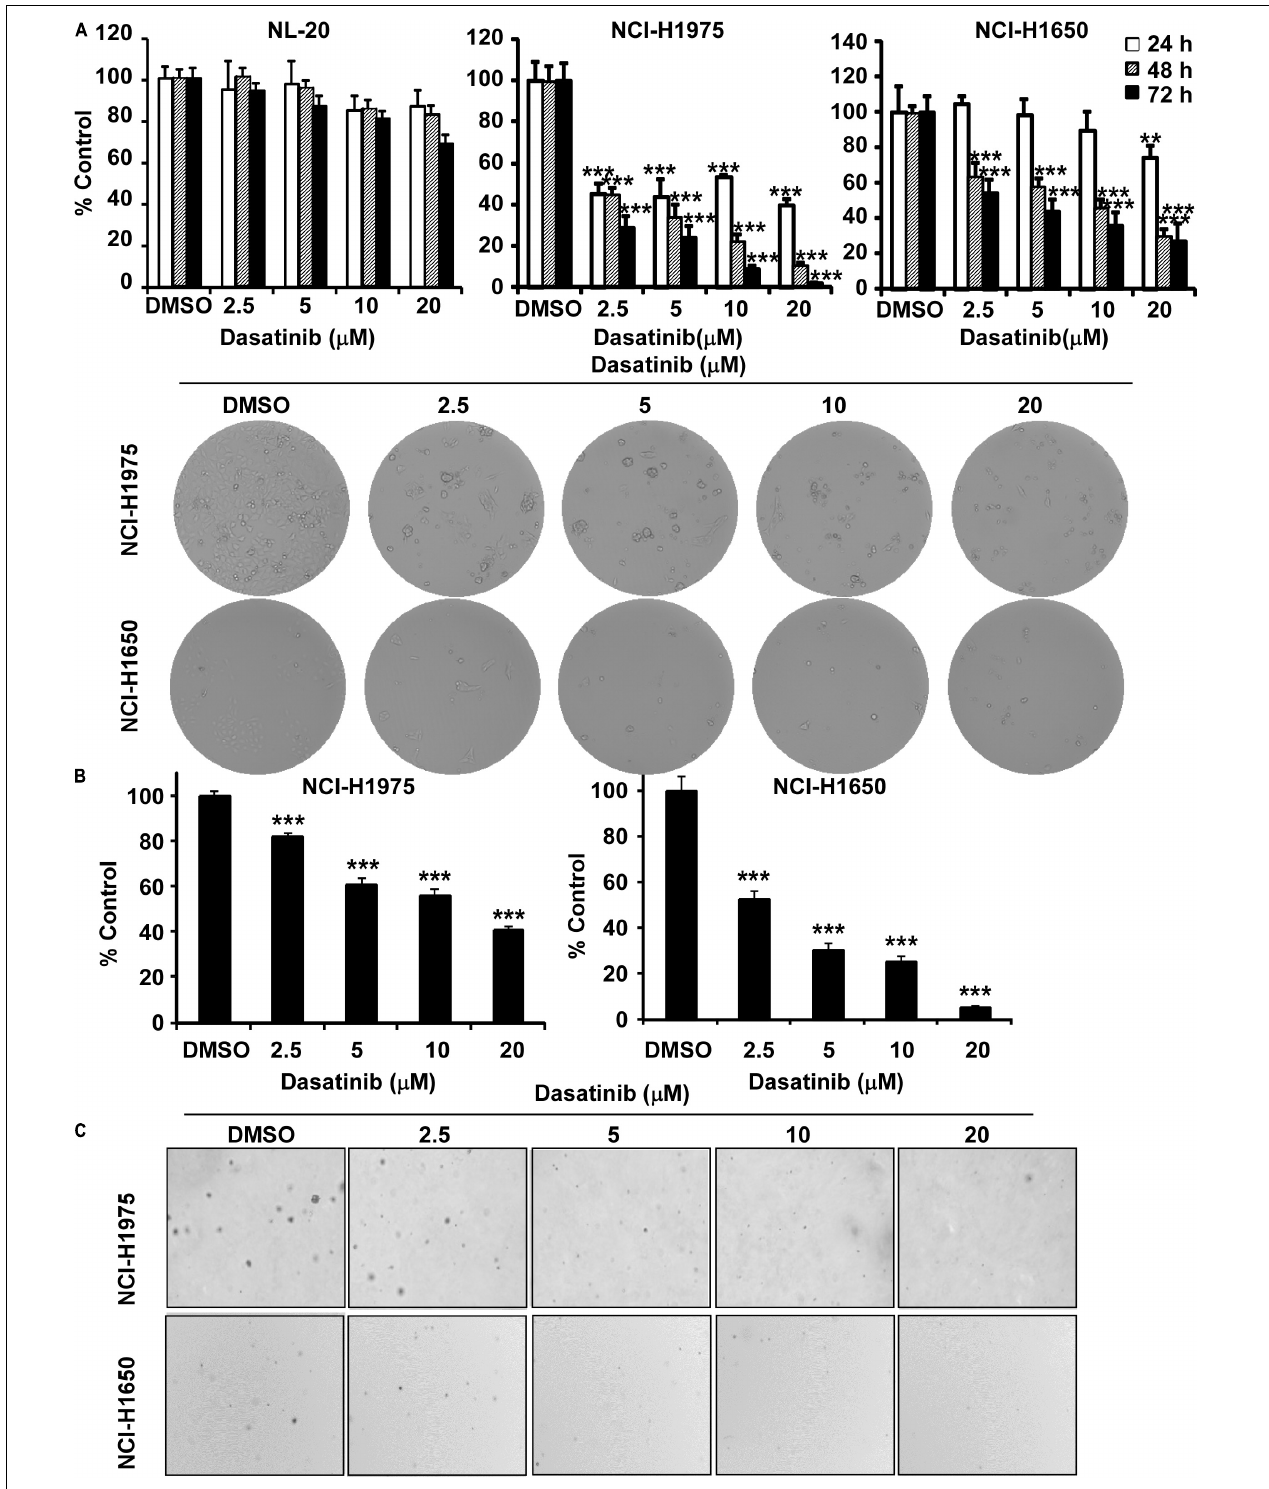
FIGURE 2 | Dasatinib inhibits lung cancer cells growth. (A) The effect of dasatinib on the proliferation of normal cells, NCI-H1975 and NCI-H1650 lung cancer cells. Cell proliferation is detected by MTT assay. Cell morphology changes of NCI-H1975 and NCI-H1650 cells after dasatinib treatment were observed by optical microscopy ( × 100). (B) The effect of dasatinib on anchorage-independent cell growth. (C) Representative photographs of anchorage-independent cell growth assay. Data are shown compared with DMSO treated cells. **, ***, statistical significance ( p < 0.01, p < 0.001) compared to controls.